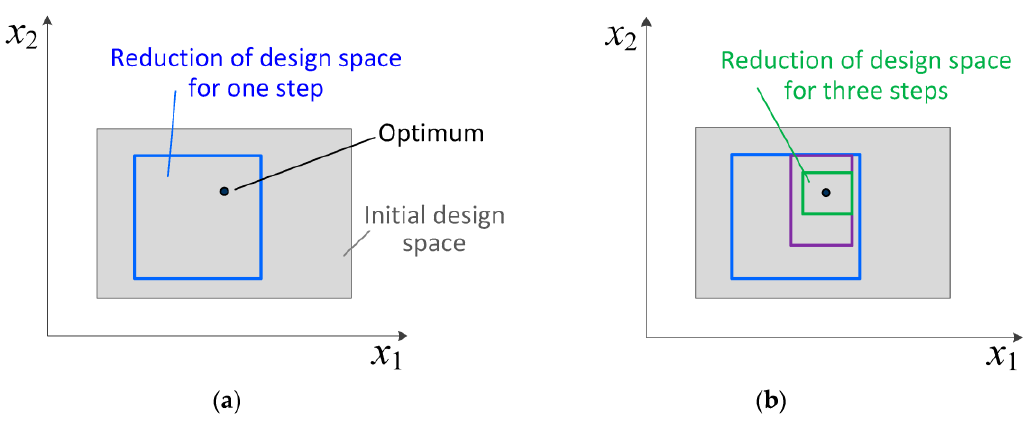
Figure 6. Illustration of the space reduction method in the SOM, ( a ) one step; ( b ) three steps.